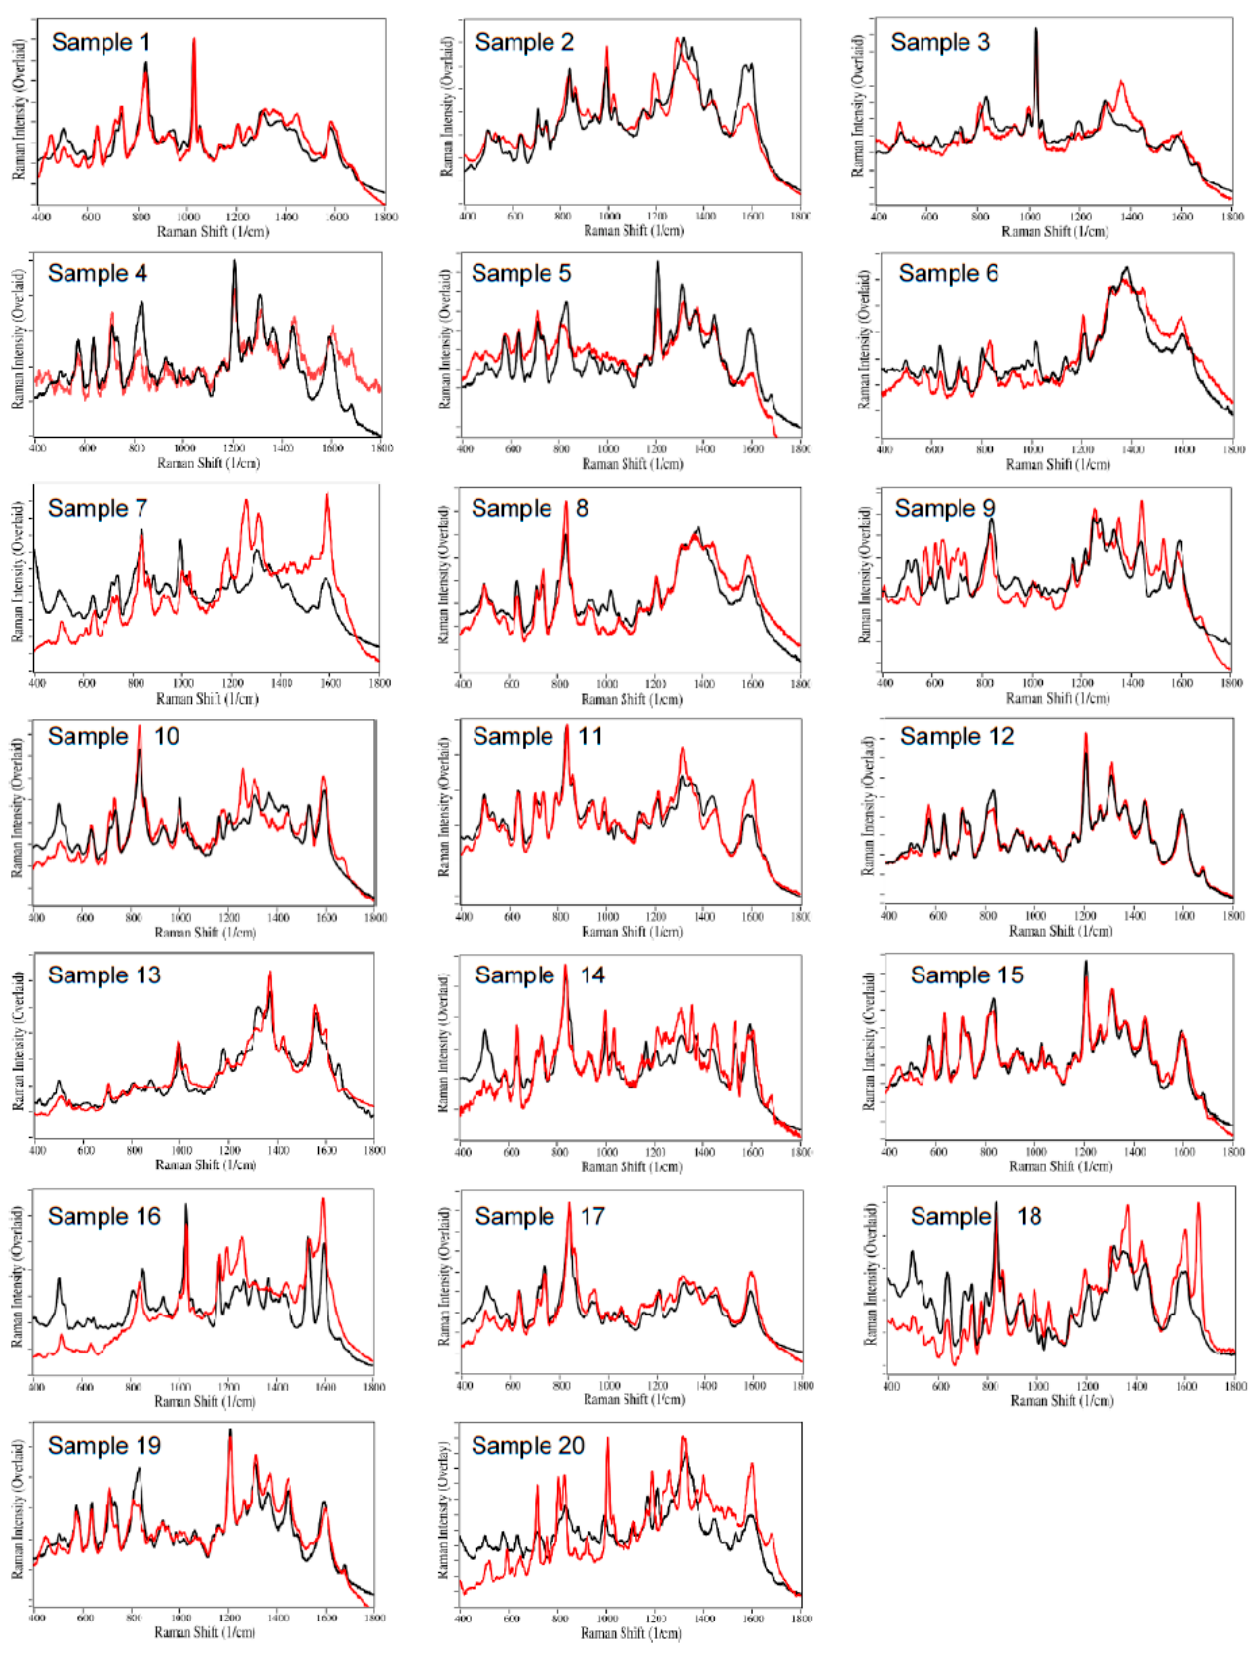
Figure 2. SERS of VACHS Samples 1 to 20. Actual spectra (red) are fit by the S-Quant software (black). Spectral conditions as in Figure 1.